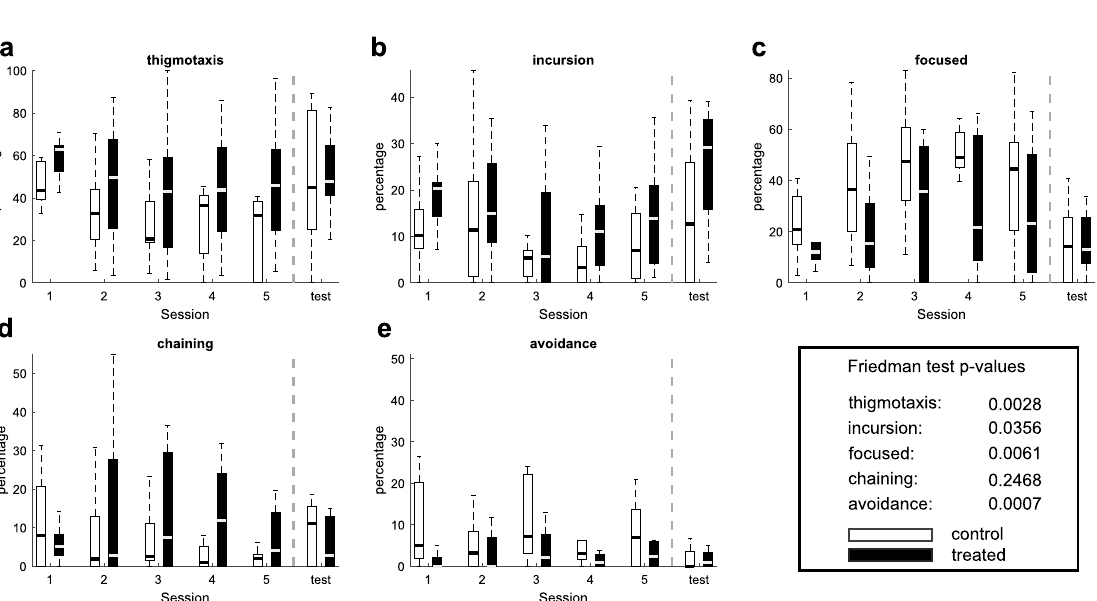
Figure 3. Percentage of subsegments falling under each behaviour for the treated (black) and control (white) animal groups over each session. All the animals were tested for a set of 5 sessions followed by one memory retrieval test. The Friedman test p-value (shown in the legend) was used to compare both animal groups during the five experimental sessions. According to the plots there are significant differences among the two groups in the behaviours: thigmotaxis ( a ) and incursion ( b ) in favour of the treated group ( p -value equal to 0.0028 and 0.0356) and avoidance ( e ) and focused ( c ) in favour of the control group ( p -values equal to 0.0007 and 0.0061). These results suggest that the control animals attempt to distance themselves from the arena periphery and remain in a specific area of the arena (focused) which supports proper task performance (avoidance), while the treated animals move on periphery (thigmotaxis) or move into the inner part of the arena (incursion). This behaviour did not allow effective avoidance of the sector to-be-avoided, which would indicate that rats from treated group were unable to remember the location of the shock sector and to avoid it when they were close to it. This is consistent with the avoidance efficiency measurements in Fig. 1 (number of entries, number of shocks, maximum time avoided) which indicate impaired avoidance in treated animals compared to the controls. No significant difference was found for chaining ( d ), which is passive transportation of sitting animals by the